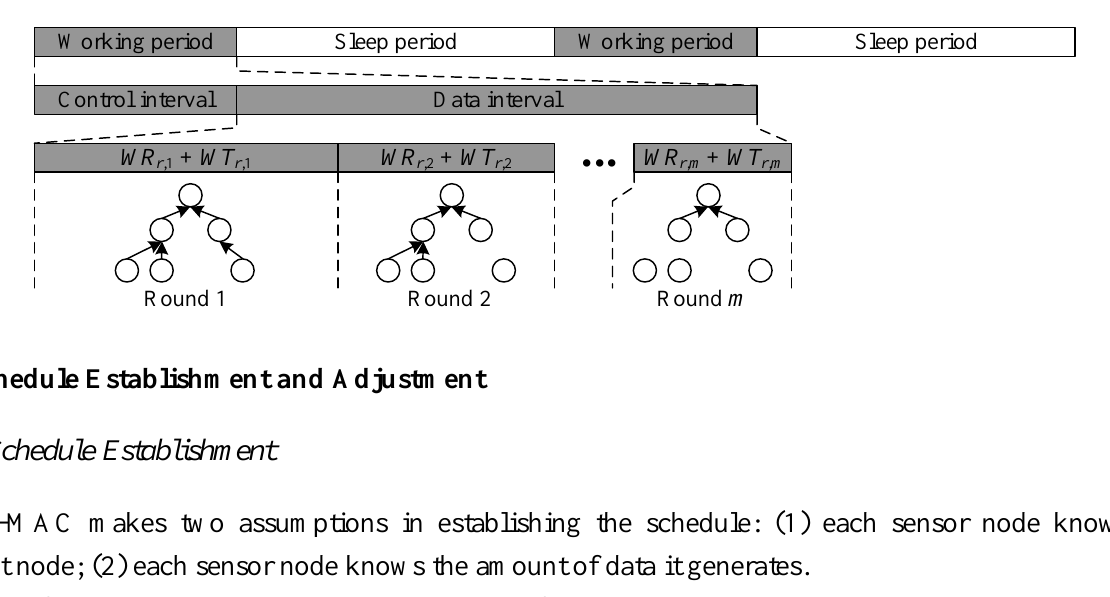
Figure 4. Scheduling of multi-rounds